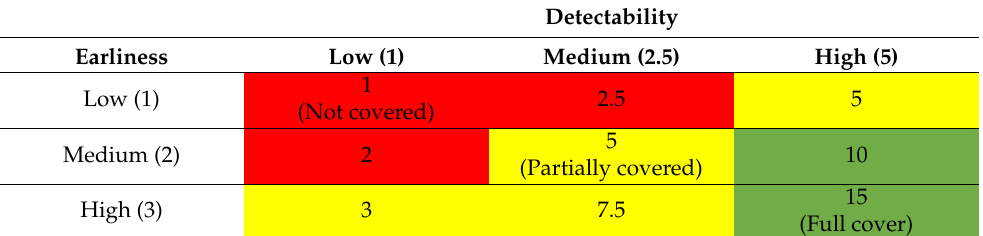
Table 3. Detection priority index.